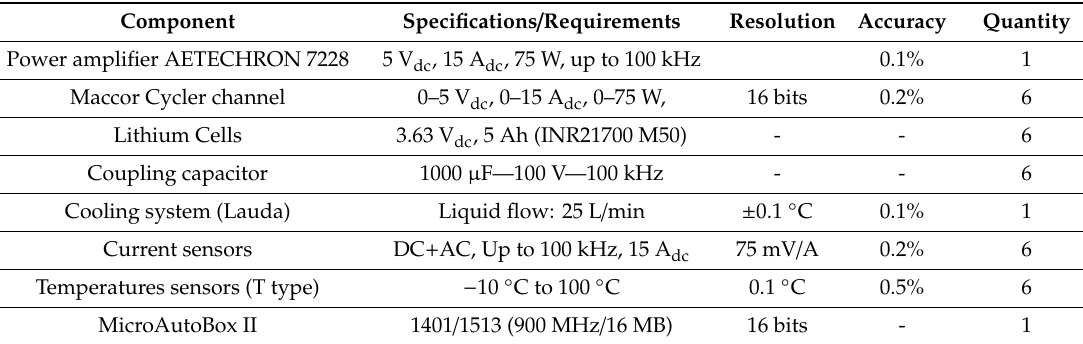
Table 2. Test rig components specification.